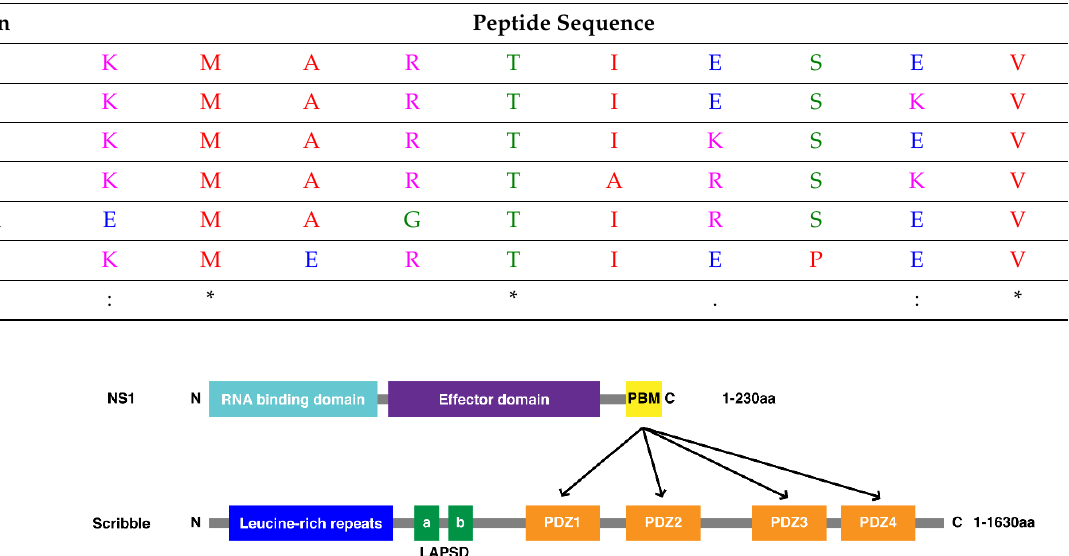
Table 1. Overview of NS1 PBM motif peptides. (A) Sequence alignment of NS1 peptides and superpeptide created with Clustal Omega 1.2.4 multiple sequence alignment (https://www.ebi.ac.